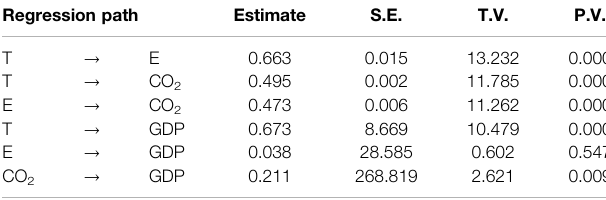
TABLE 3 | Regression weight SEA region.